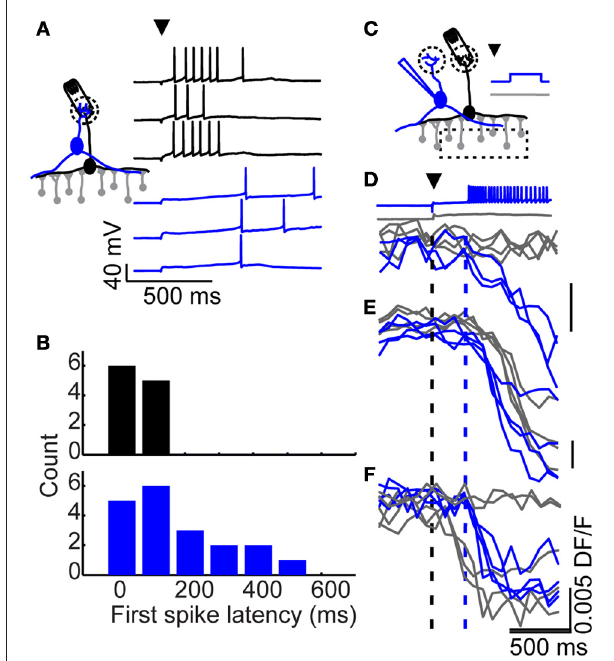
FIGURE 3 | Long-latency excitation comes from tufted, but not mitral cells. (A) Example of a mitral cell (black) and tufted cell (blue) response to glomerular stimulation (arrowhead). (B) Distribution of first spike latencies following glomerular stimulation in mitral (black) and tufted cells (blue). (C) Optical imaging setup. A stimulating electrode was impaled into a glomerulus and a nearby (but not connected) tufted cell was patched. The glomerulus was stimulated on every trial, while the tufted cell was made to fire on every other trial. Responses from three granule cells (D–F) to glomerular stimulation with (blue) and without (gray) additional tufted cell input were monitored optically. Black dash denotes timing of glomerular stimulation, blue dash denotes onset of tufted cell activity for tufted stimulation trials